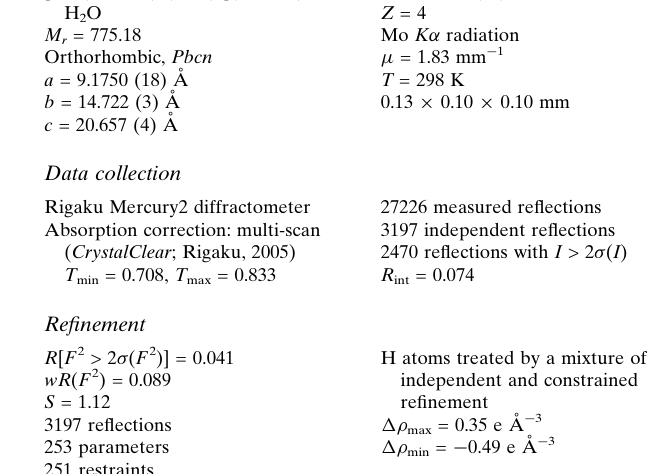
27226 measured reflections 3197 independent reflections